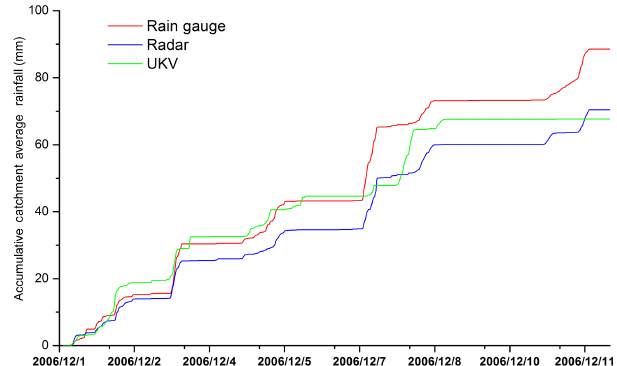
Figure 4. The comparison of flow simulation in HYPE (event De- cember 2006).